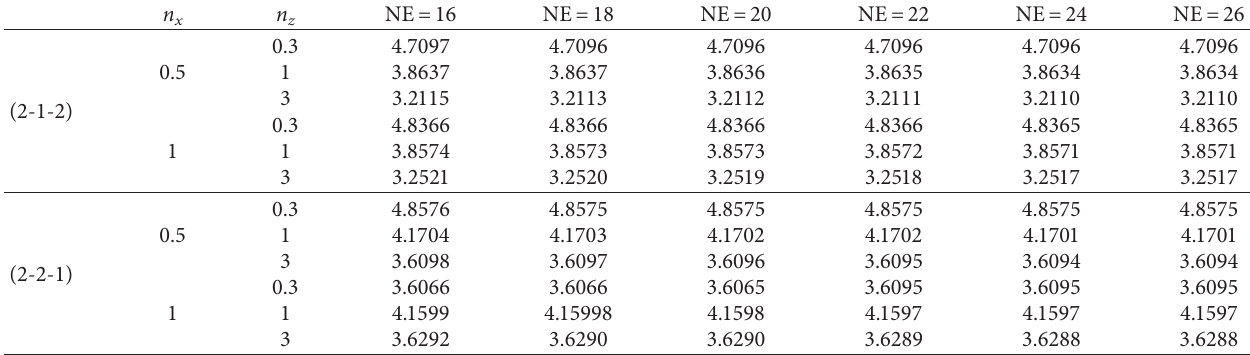
Figure 4: Comparison of time histories for midspan dimensionless deflection of unidirectional FGM Sandwich beam ( L / h � 10, n v � 50m/s). Table 3: Convergence of the element in evaluating frequencies of BFGSW beam ( L / h �